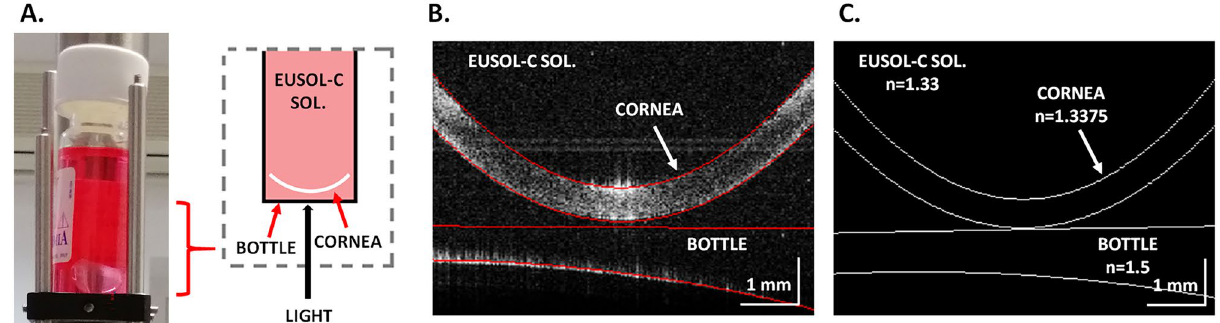
Figure 1. Diagram showing the method of measuring donor’s corneas using a sterile vial and custom made SS-OCT device in the eye bank. ( A ) Sterile vial with the donor’s cornea and its position in relation to the light source. ( B ) OCT scan obtained during experiment showing hyperreflective structure—donor’s cornea—near the bottom of the vial. ( C ) Diagram with marked refractive indexes of the donor’s cornea, Eusol-C solution and the vial used for